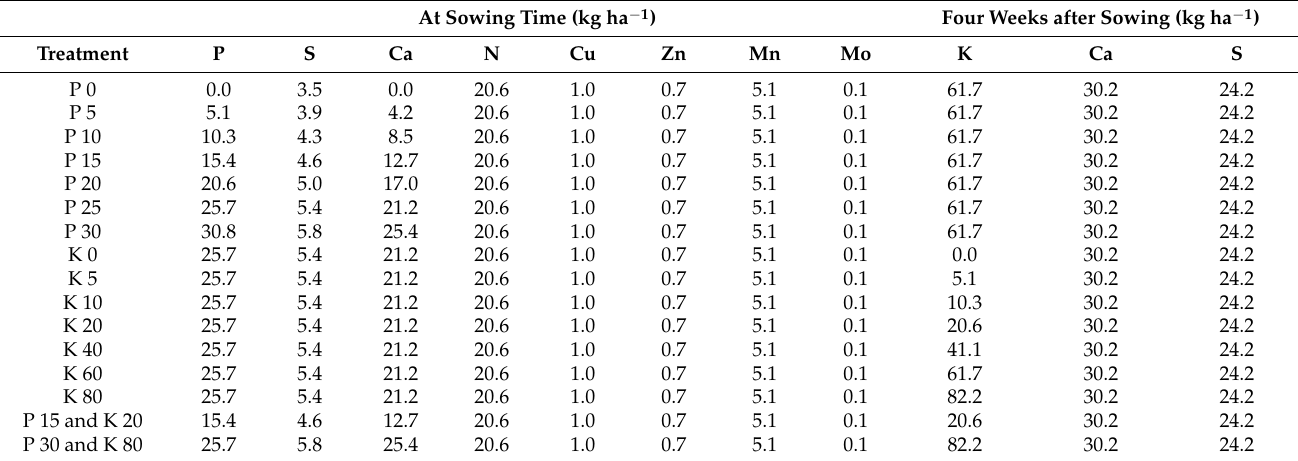
Table 2. Nutrients (kg ha − 1 ) applied at sowing time or four weeks after sowing to generate the seven levels of P, seven levels of K and the two P and K